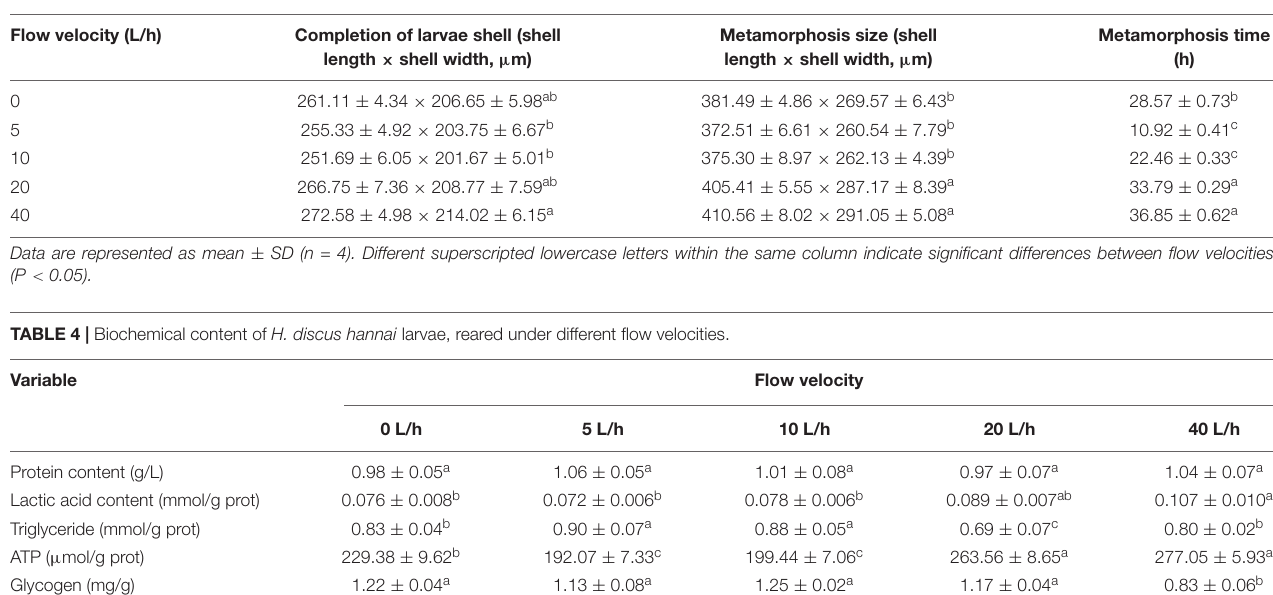
TABLE 3 | Performance of H. discus hannai larvae from completion of larvae shell to metamorphosis according to flow velocities.